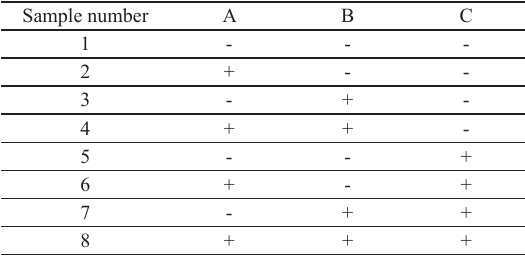
Table 2. Matrix of